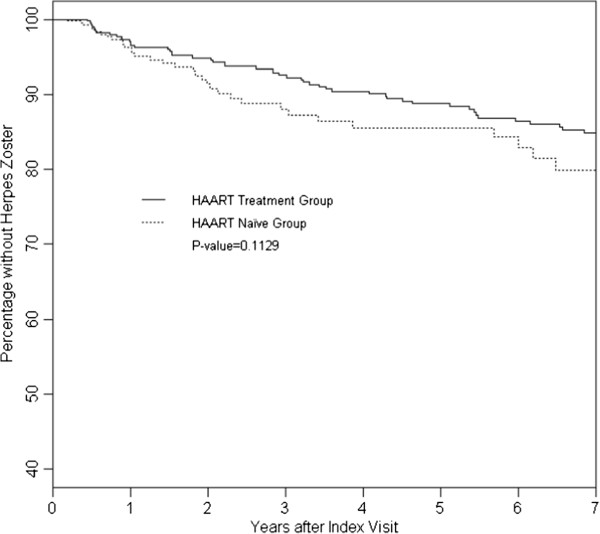
Percentage without herpes zoster for HAART treatment and HAART naïve group.